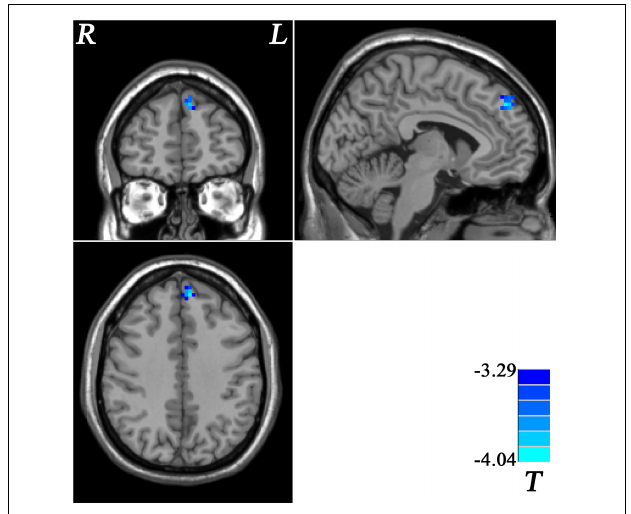
FIGURE 2 | Statistical map depicts lower GFC of MDD patients with GI symptoms compared with MDD patients without GI symptoms. Blue denotes lower GFC. Color bar indicates T values from two-sample t -test. MDD, major depressive disorder; GFC, global functional connectivity; GI, gastrointestinal